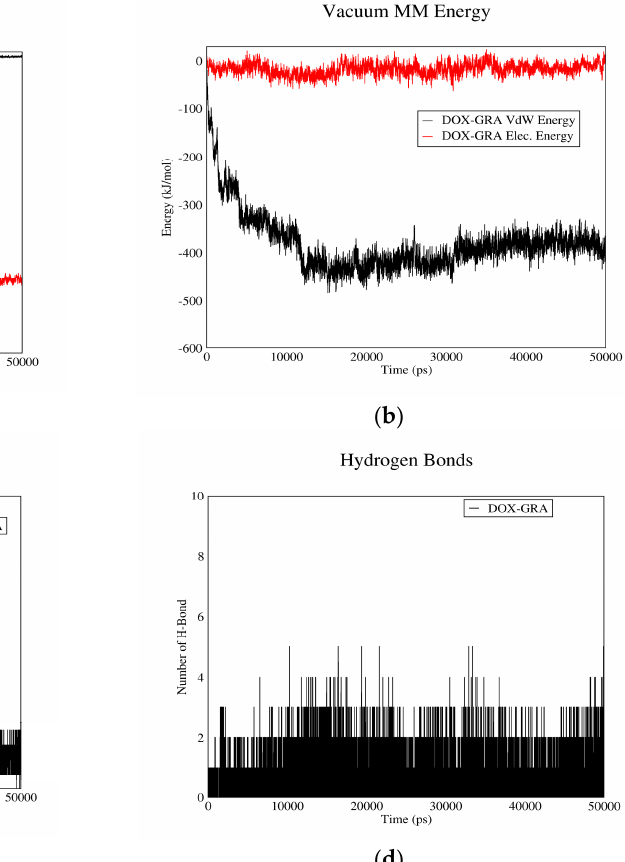
Figure 3. DOX–GO interaction energies and hydrogen bonds: ( a ) electrostatic and Van der Waals energies of DOX–GO interaction versus time in neutral pH; ( b ) electrostatic and Van der Waals energies of DOX–GO interaction versus time in acidic pH; ( c ) the number of hydrogen bonds between DOX and GO versus time in neutral pH; ( d ) the number of hydrogen bonds between DOX and GO versus time in acidic pH.